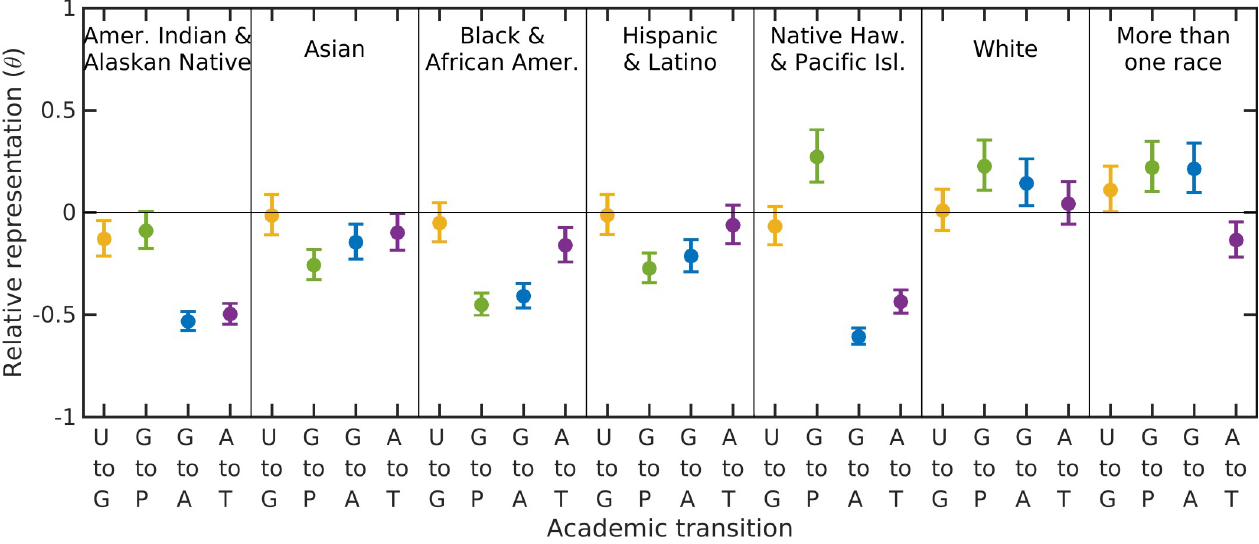
Fig 4. Relative representation across transitions. The relative representation ( θ [Eq 1]; comparing data and the null model) over 15 years (1991–2016) of each race/ethnicity category through one of the transitions within academia: undergraduate to graduate student (U to G), graduate student to postdoctoral researcher (G to P) or to assistant professor (G to A), and assistant to tenured professor (A to T). Positive or negative values indicate a race/ethnicity category faces correspondingly positive or negative bias across that transition. Confidence intervals mark the range of θ values that result from a 5% increase or decrease in representation in either the data or